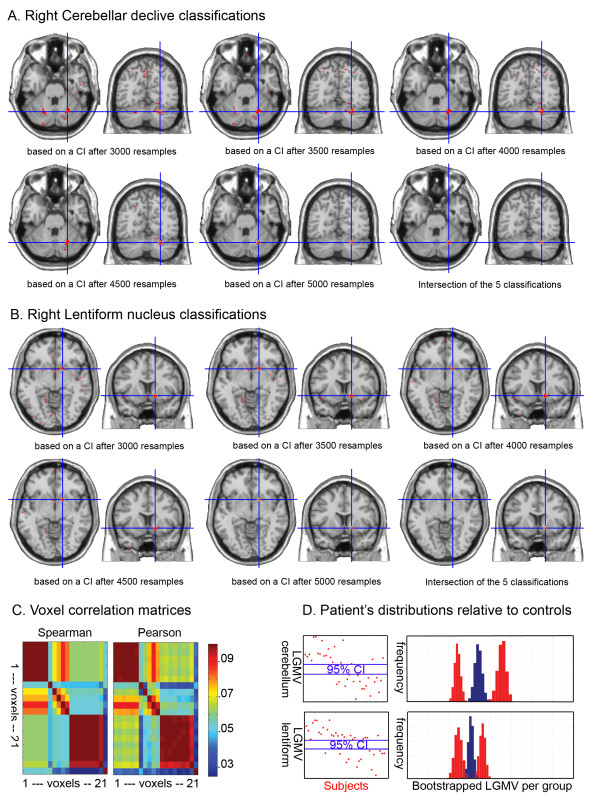
Illustration of the results of the classification performed on the dyslexic subjects. In A and B, the right cerebellar and lentiform nucleus clusters observed for each classification are presented (classification performed on CI computed after 3000, 3500, 4000, 4500 and 5000 resamples) as well as the final classification (the average of previous classifications). Each cluster was homogenous as illustrated in C: Among the 21 voxels showing 100% of differences between groups, two clusters can be observed with a correlation of ~1, i.e. voxels in each cluster have identical classification values (Spearman rank correlation), and identical (or nearly identical) grey matter volume values (Pearson correlations). As illustrated in D, all dyslexic subjects (red dots) were located outside the bootstrapped 95% CI (blue lines) of local grey matter volumes (LGMV). Those values are the observed value in each voxel and derived from preprocessing (step 1). Simulations (5000 resamples) of the dyslexics' distributions (red histograms) compared to the control distributions (blue histograms) show a clearer separation over the right cerebellum compared to the lentiform nucleus.